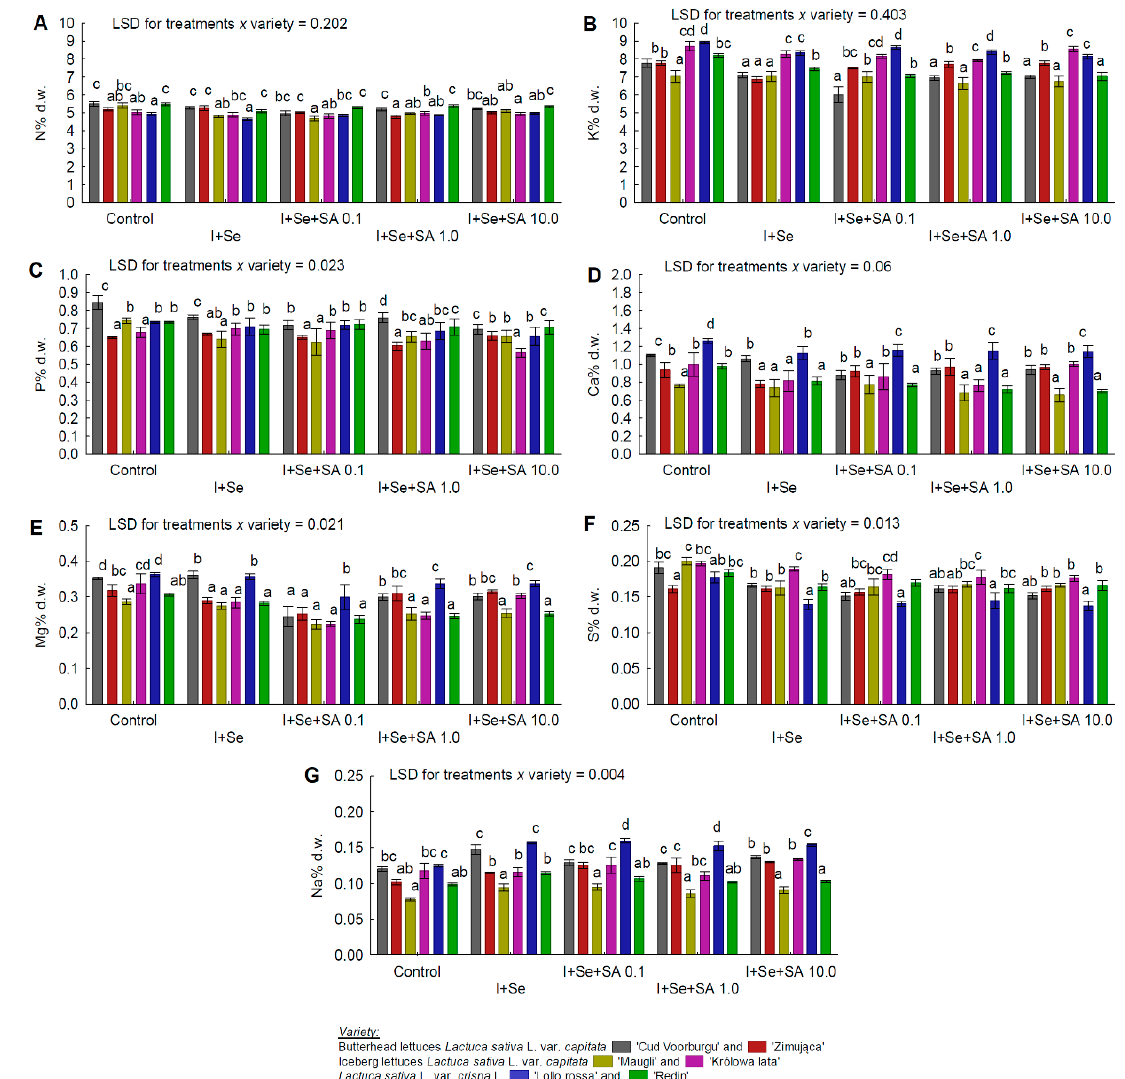
Figure 5. Concentrations of macronutrients: N ( A ), K ( B ), P ( C ), Ca ( D ), Mg ( E ), S ( F ), and Na ( G ) in lettuce. Means for cultivars followed by the same letters separately for each treatment (type of nutrient solution) are not significantly different at p < 0.05. LSD for interaction “treatments × variety” at p < 0.05. Bars indicate standard errors ( n = 8). d.w.—dry matter weight.